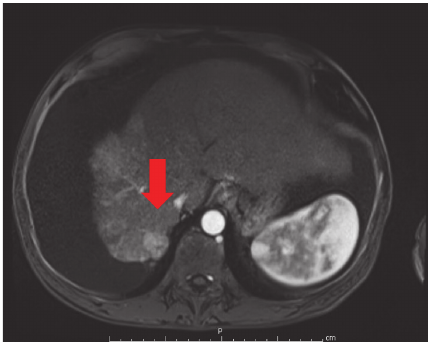
Figure 1: MRI image of an arterially enhanced lesion representing hepatocellular carcinoma seen with washout and delayed capsular enhancement.Thetumormeasures2.2 cmindiameterandislocated on segment 7 of the liver in close proximity to the tendinous portion of the right